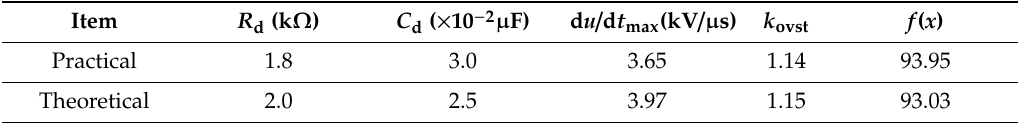
Table 2. Comparison Between The Practical and The Optimized